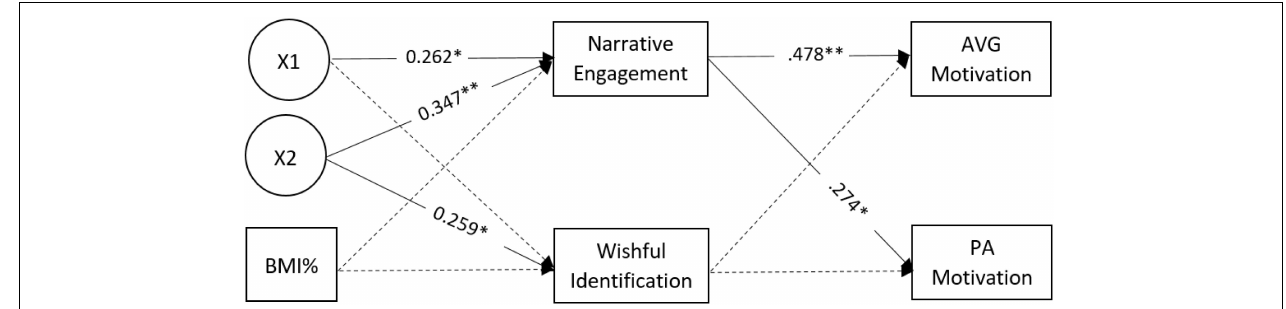
FIGURE 2 | Structural Equation Model for the relation between character body shape, children’s BMI percentile, AVG motivation and PA motivation, with narrative engagement and wishful identification as the mediating variables. X1: the overweight/obese condition in reference to athletic slim condition. X2: the average condition in reference to athletic slim condition. All paths’ estimates are standardized. For the sake of simplicity, the direct and indirect paths from the IVs to the DVs as well as the correlations between the mediators and DVs are not shown. ∗ p < 0.05; ∗∗ p <